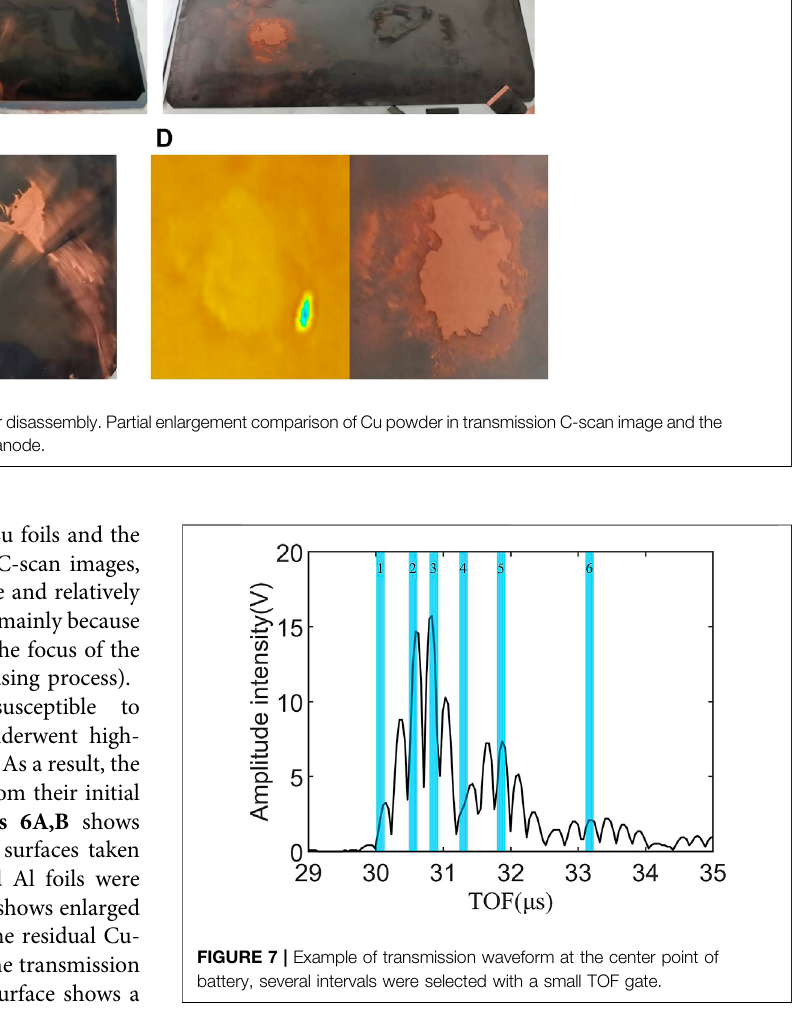
Frontiers in Energy Research |